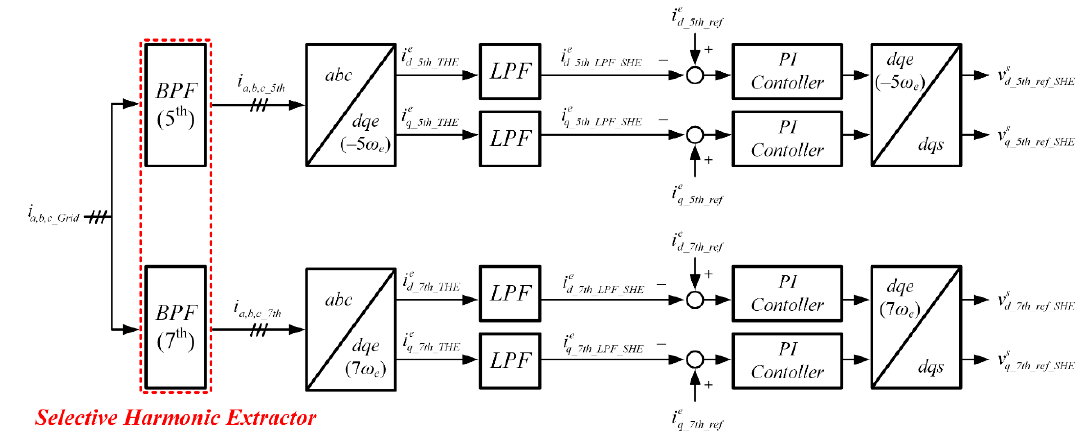
Figure 9. Block diagram of the SHE (selected harmonic extractor) method.